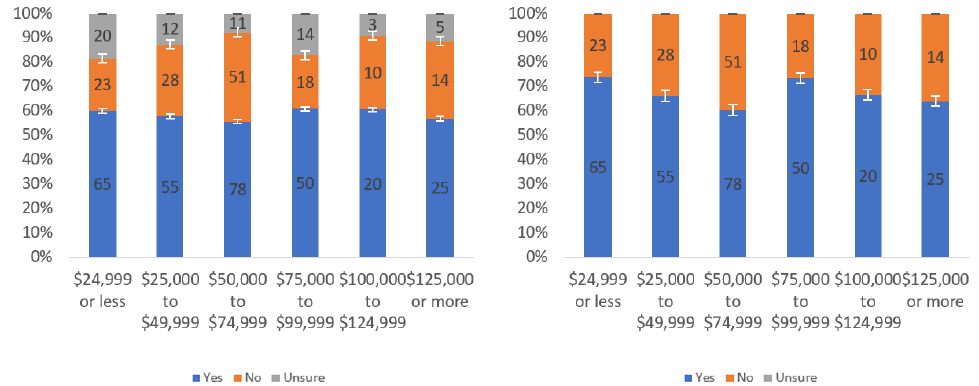
Figure A16. Responses regarding label helpfulness by income level including ( left ) and excluding ( right ) unsure responses.